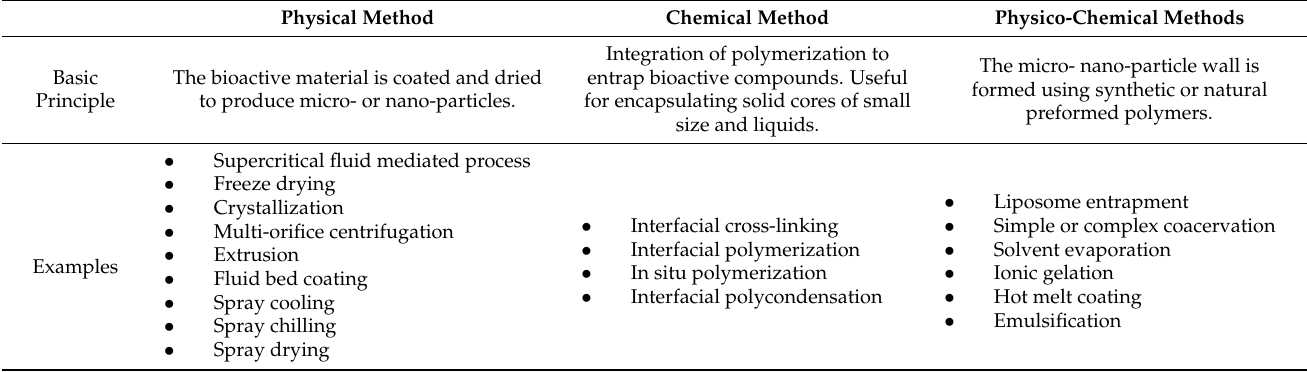
Table 1. Summary of methods used to encapsulate bioactive compounds and materials